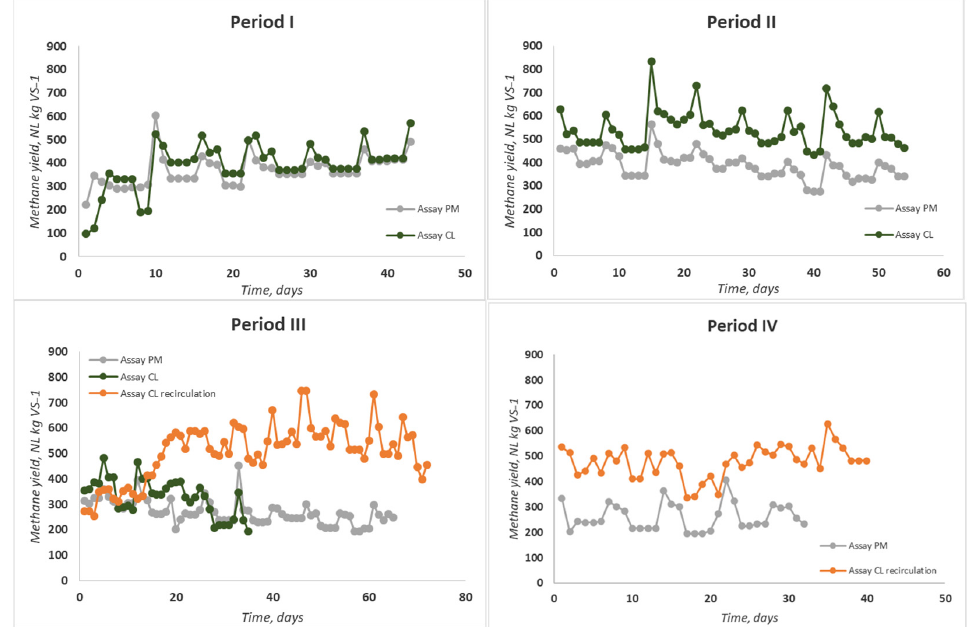
Figure 3. Methane yield evolution for each studied period at different OLRs.